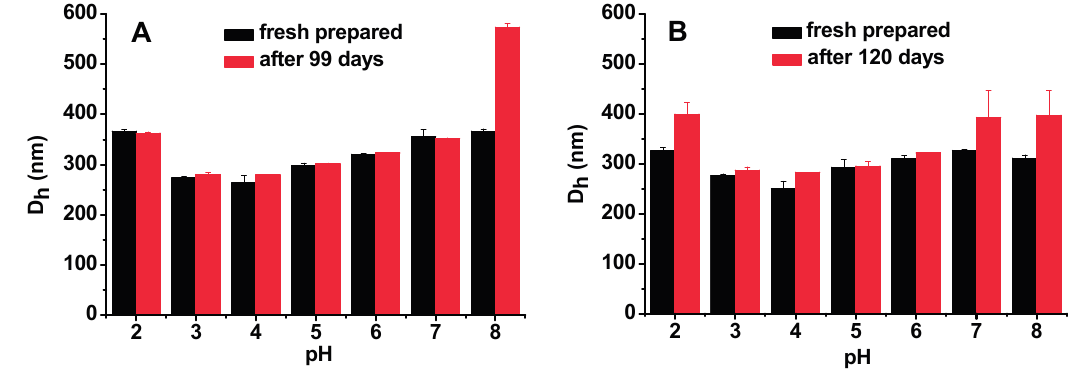
Figure 7. Droplet size changes of ( A ) Complex3 and ( B ) Complex4 emulsions before and after storage at 4 °C in different pH media without